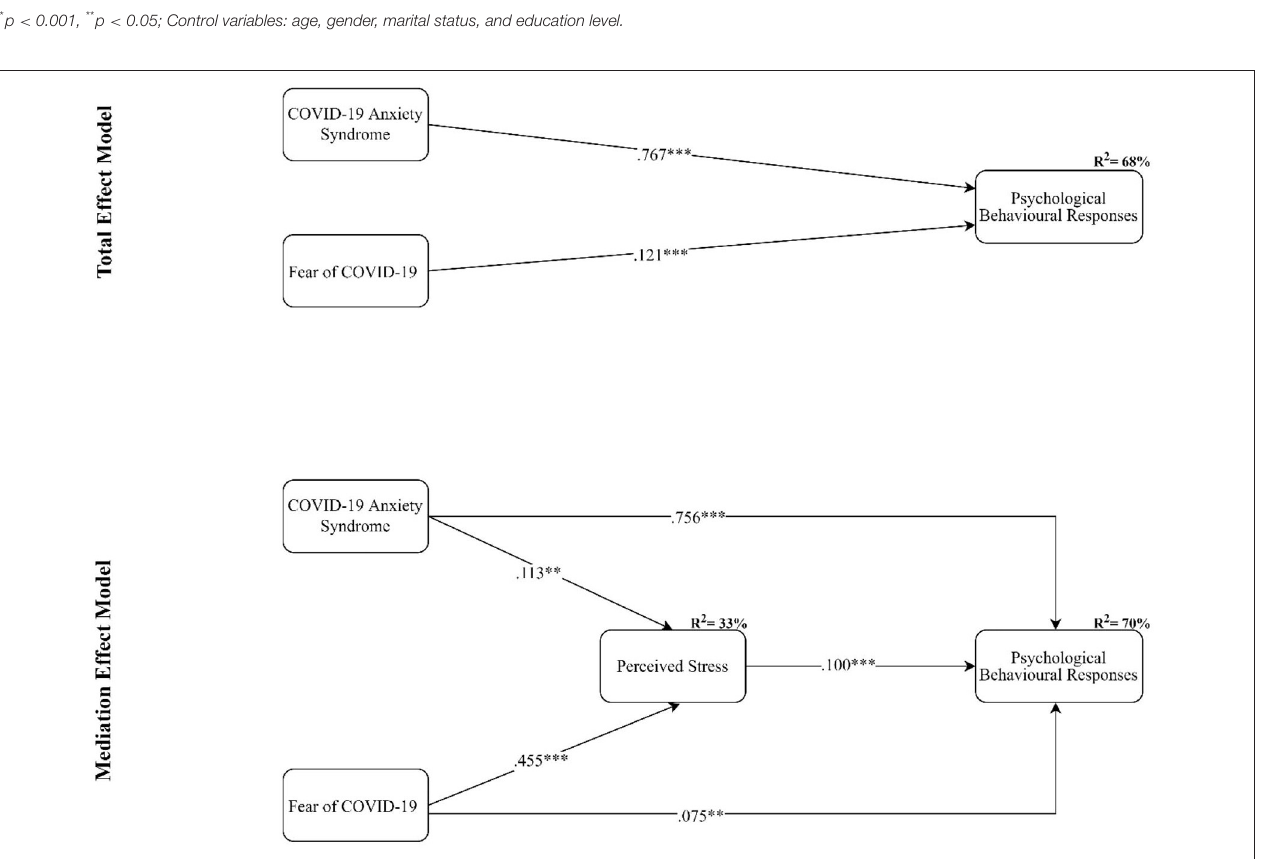
FIGURE 1 | The results of the structural model assessment; *** p < 0.001, ** p < 0.005; Control variables: age, gender, marital status, and education